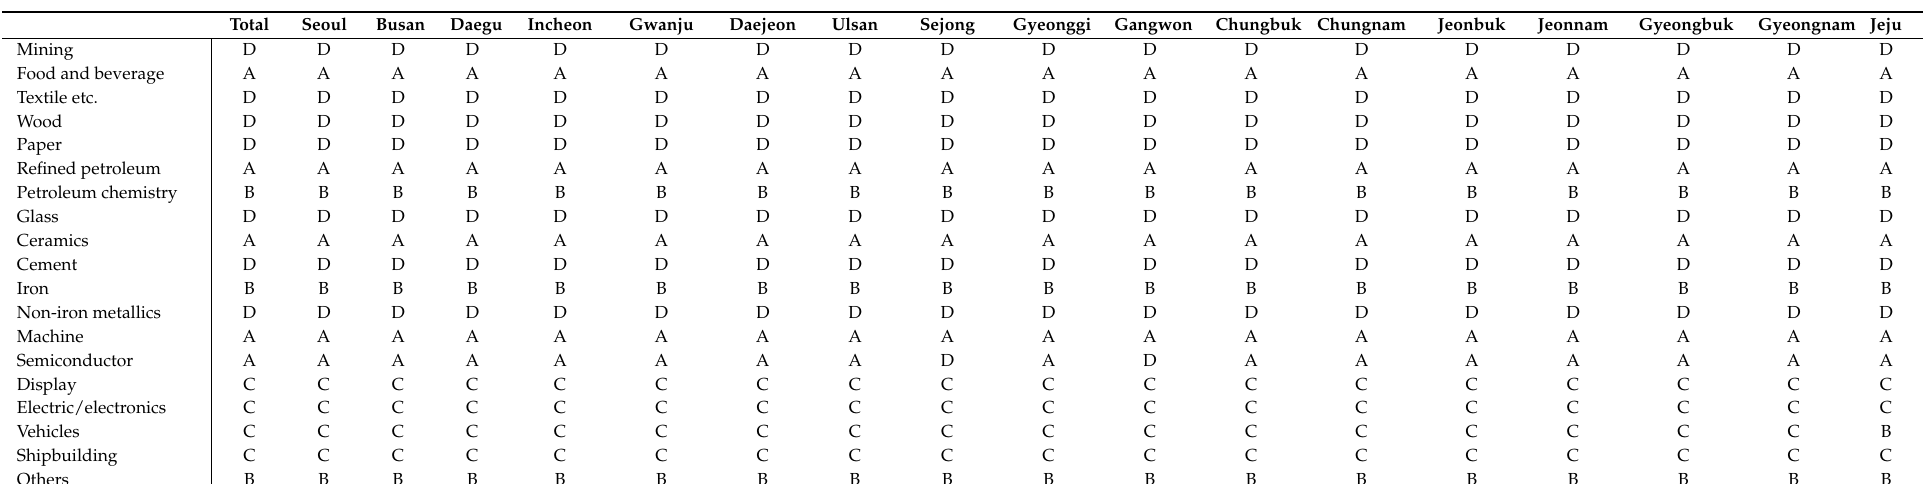
Table 6. Location of each MM industry in 17